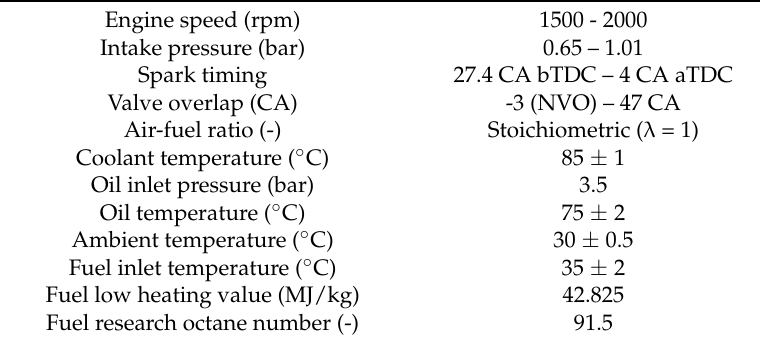
Table 3. Engine experimental conditions.